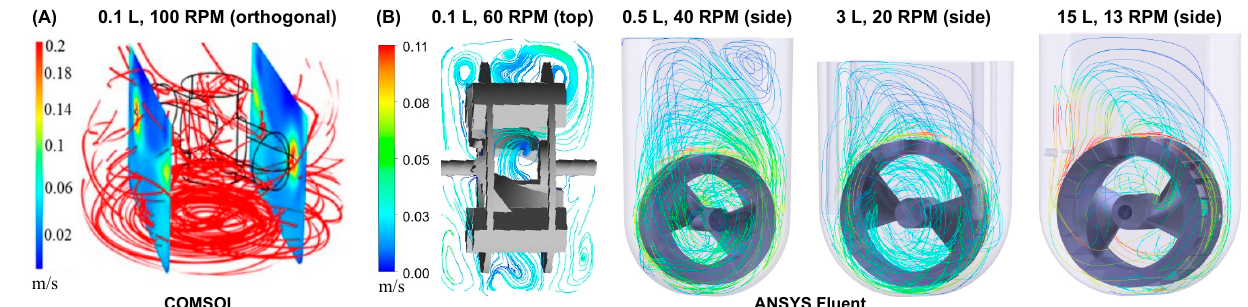
Figure 1. CFD models of velocity streamlines for ( A ) horizontal-blade spinner and ( B ) VW bioreactors. All agitation rates are sufficient to fully suspend large particles such as cell aggregates. An identical modeling method was used for both fluid simulation softwares (COMSOL and ANSYS Fluent). Adapted from Borys et al. (2018) [27].